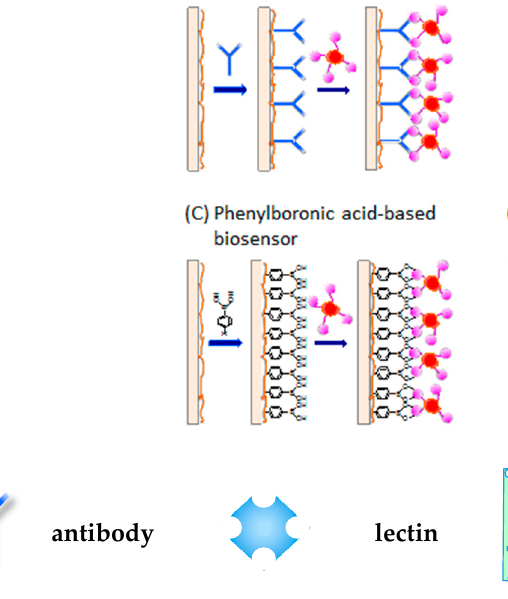
Figure 1. Different types of glycoprotein biosensors based on ( A ) antibody; ( B ) lectin; ( C ) phenylboronic acid; and ( D ) molecular imprinted polymer.